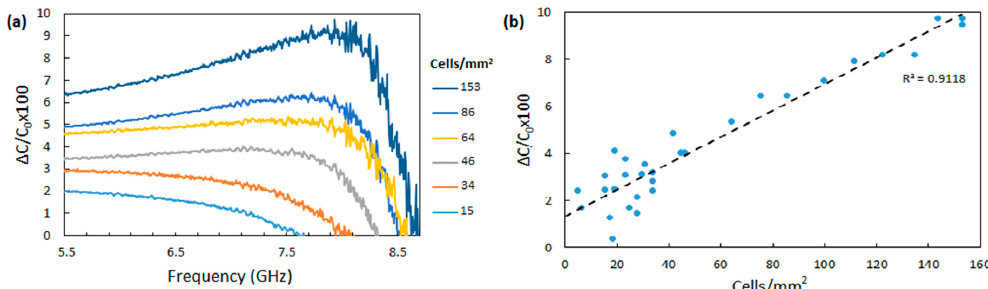
Figure 5. Results of the relative capacitance measurement for various concentrations of Cryptosporidium . ( a ) Relative capacitance change measurements for different concentrations of Cryptosporidium for samples ranging from 15 cells/mm 2 to 153 cells/mm 2 . ( b ) The calibration curve generated from capacitance measurements.